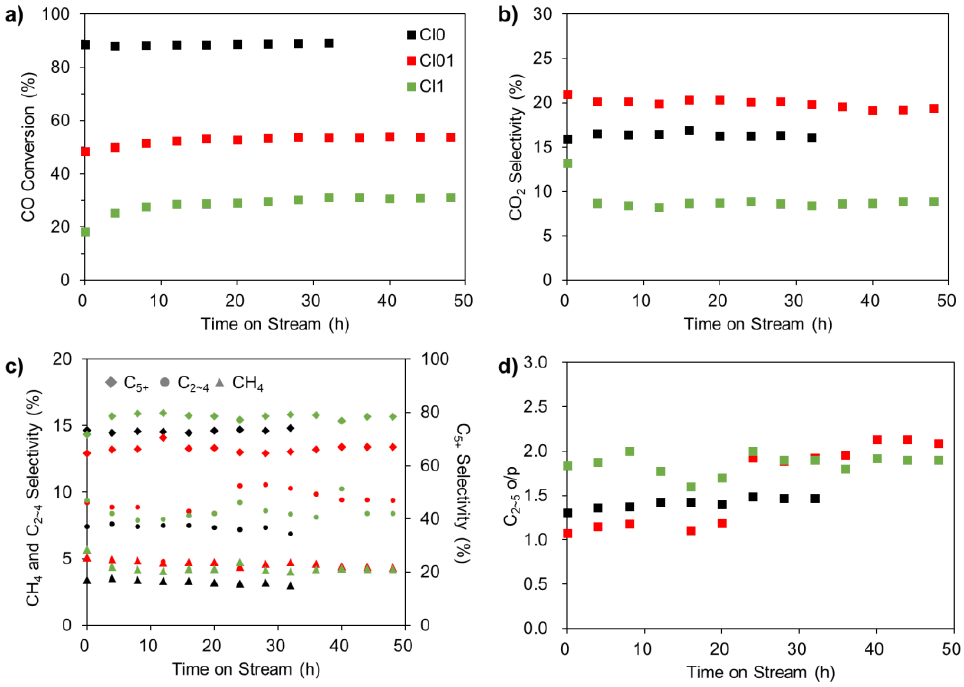
Figure 3. ( a ) CO conversion, ( b ) CO 2 selectivity, ( c ) hydrocarbon product selectivity, and ( d ) C 2~5 o/p value versus time on stream over Cl0, Cl01, and Cl1 catalyst. Table 2. Fischer–Tropsch synthesis performance of precipitated iron catalysts 1 .